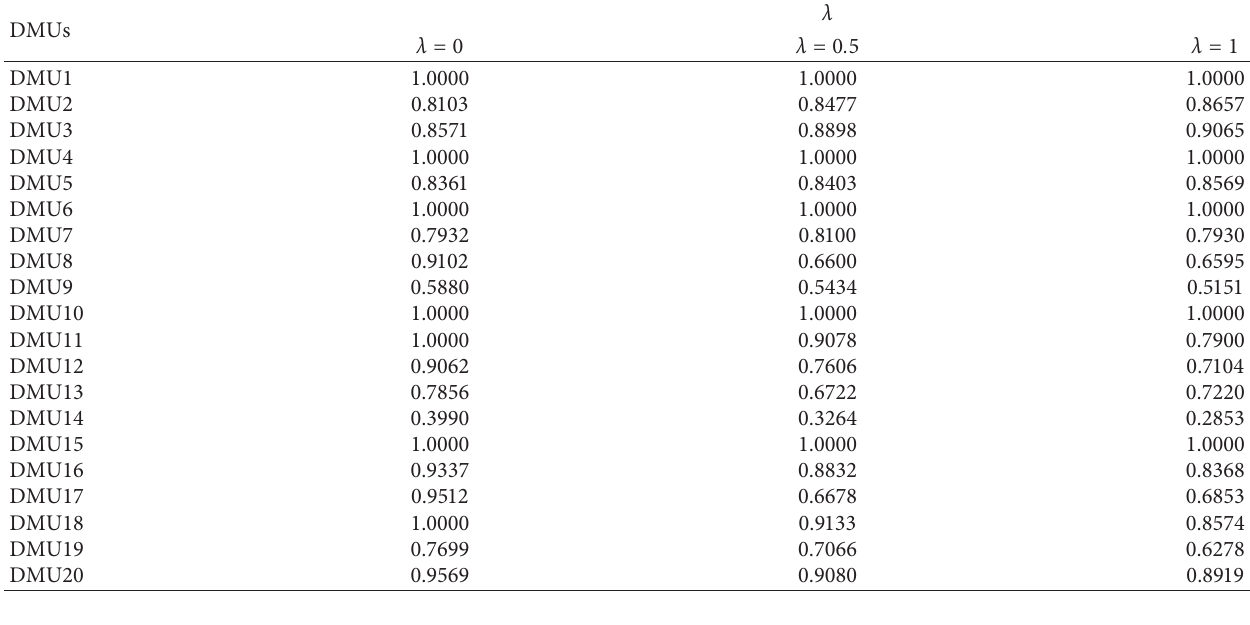
Table 4: The relative efficiency of DMUs for results’ stage.